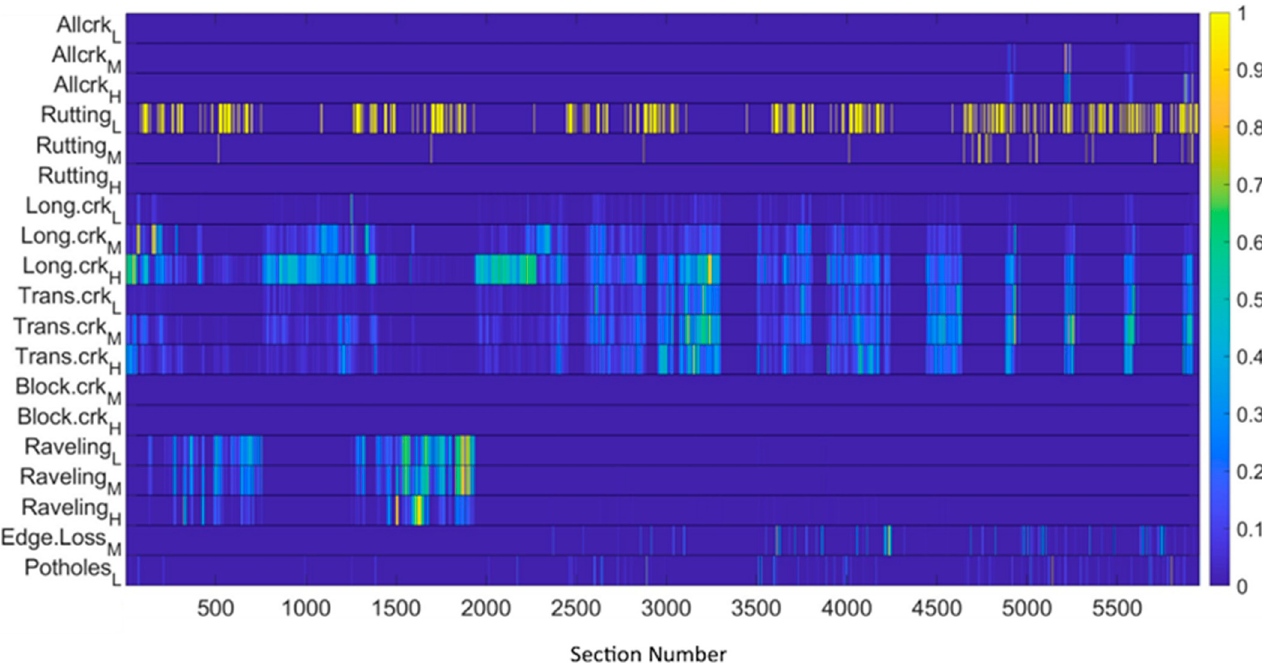
Figure 14. The maximum measured values for each of the metrics.